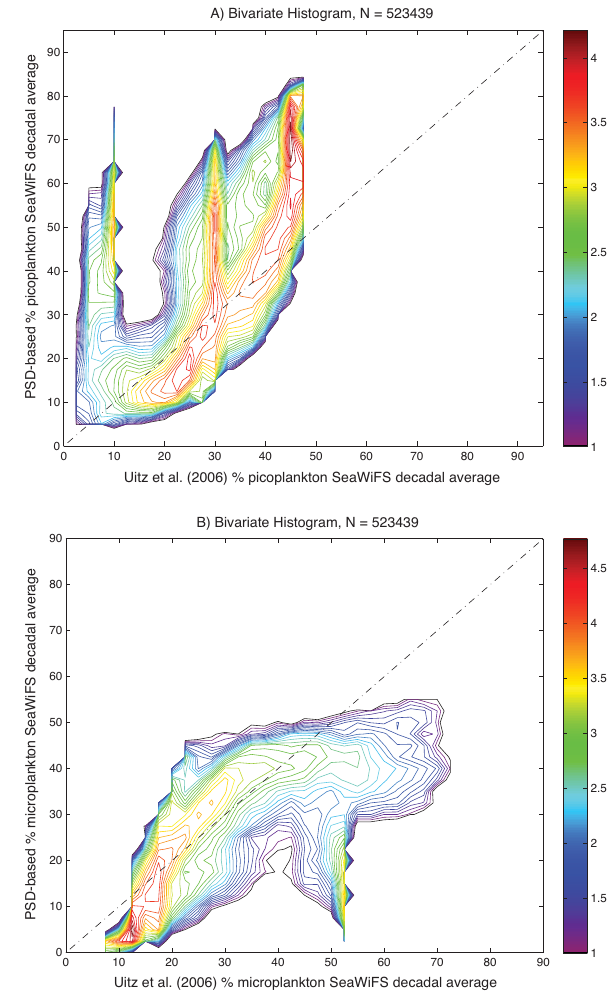
Fig. 11. Comparison of the L wN ( λ) -based PFT method of Alvain et al. (2008) with the PSD-based PFT method presented here. The January (A) and July (B) global SeaWiFS decadal averages at 1 / 4 degree resolution were used for the comparison, considering only pixels deeper than 200m. The size classes of Alvain et al. (2008) were grouped to match our three PFT’s (picoplankton, nanoplank- ton, microplankton). All pixels that Alvain et al. (2008) categorize as either picoplankton (left set of bars) or microplankton (right set of bars) were used to calculate the respective mean and standard de- viation (shown as error bar) of our PSD-based percent picoplankton (green) and percent microplankton contribution (yellow). Thus each bar represents the mean of the PSD-derived PFT’s at all pixels that are categorically classified either as picoplankton or microplankton by the method of Alvain et al. (2008).